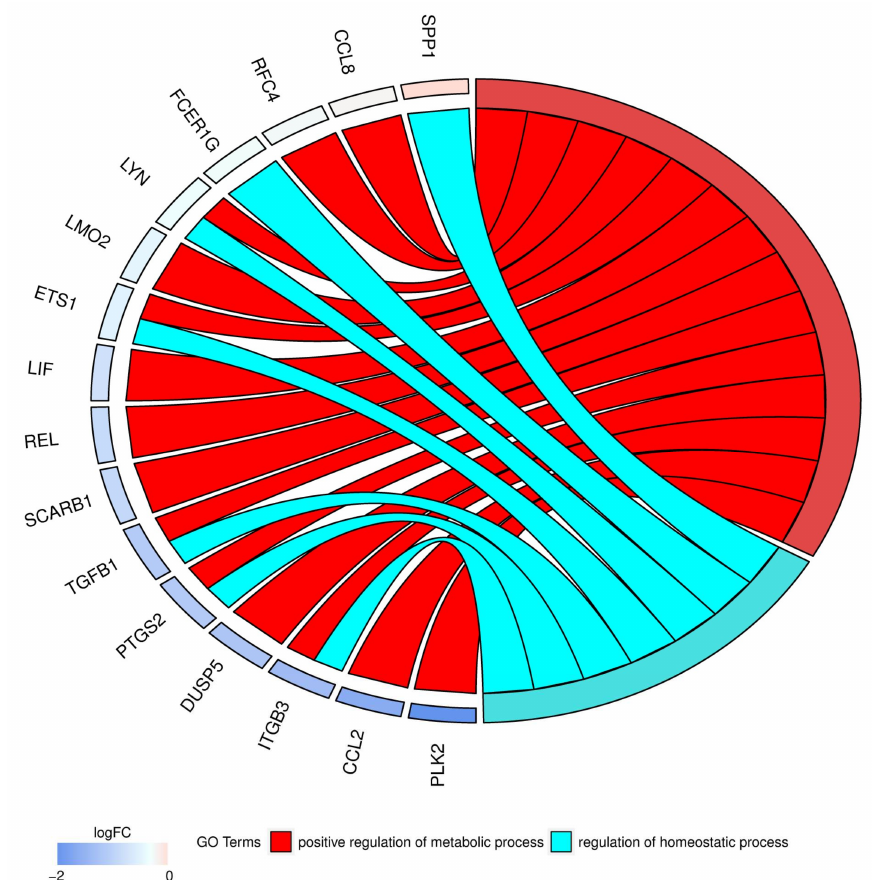
Figure 4. The representation of the relationship between differently expressed genes that belong to the “positive regulation of metabolic process” and “regulation of homeostatic process” GO terms. The ribbons show, which gene belongs to which categories. The genes were sorted by logFC from most to least changed gene. The gene that was downregulated the most, between day 7 and day 30, is presented on the bottom of the chart, the gene exhibiting the lowest amount of change is presented topmost. The intensity of the color indicates the scale of change in